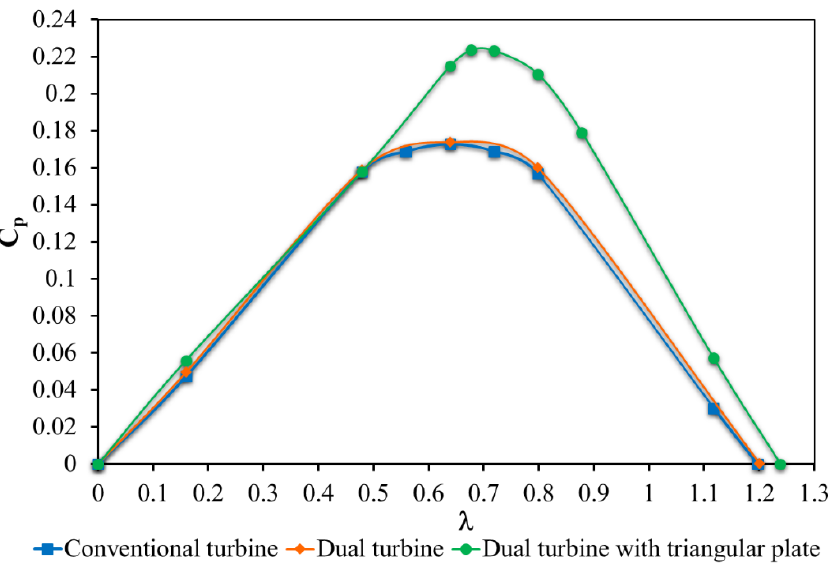
Figure 14. The effect of the triangular plate on the power coefficient.